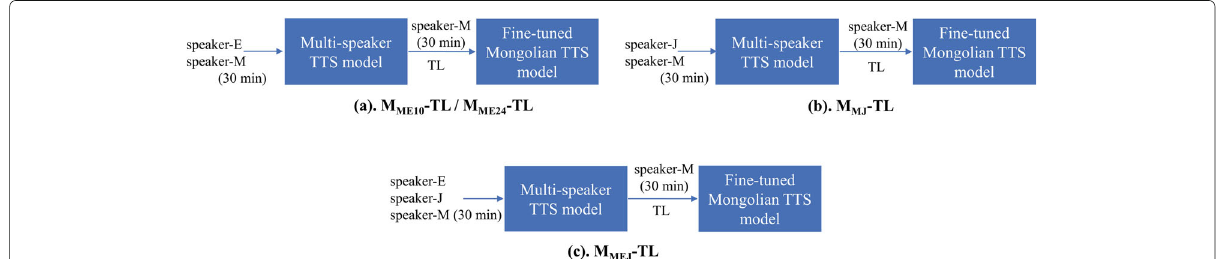
Fig. 4 Training flow diagrams for our multi-speaker TTS models. Transfer learning from the source languages to the target language is used, where a are models using the different amounts of the English dataset and the Mongolian dataset, b is a model using the Japanese and Mongolian datasets, and c is a model using the entire datasets of both high-resource languages and the Mongolian